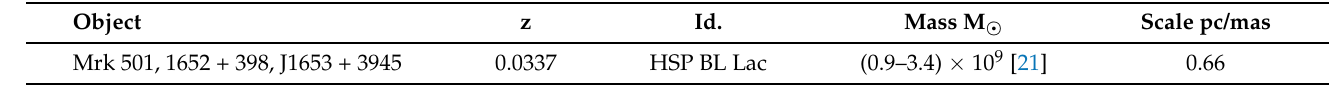
Table 1. Source name, redshift, SED classification, black hole mass, and distance scale for Mrk 501. Other than the black hole mass, the information was obtained from the MOJAVE webpage. Object